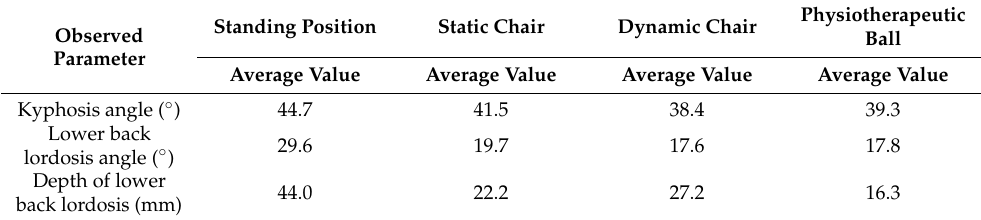
Table 1. Average values of the observed body parameters during measurements on various types of chair.